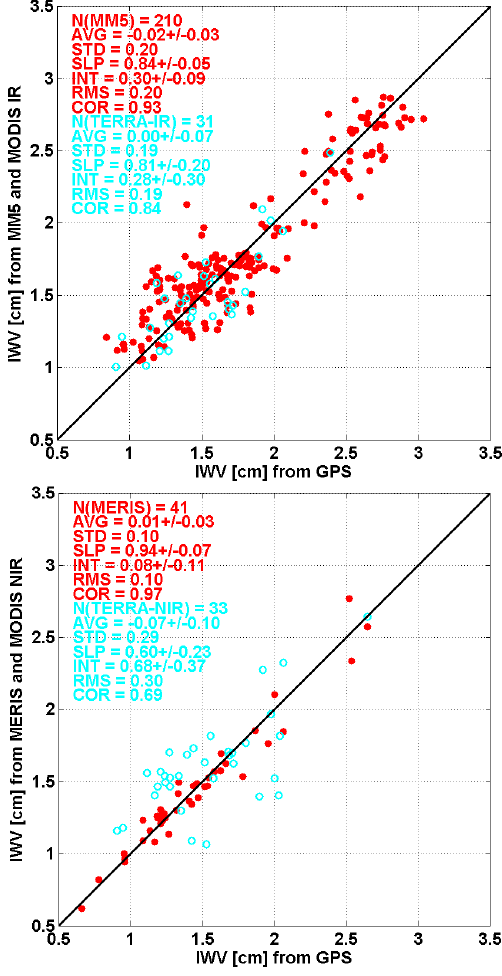
Fig. 6. Statistical comparison of IWV products from MM5 and MODIS IR (top) and MERIS and MODIS NIR (bottom) at their original horizontal resolution, against reference IWV from GPS net- work (as in Fig.